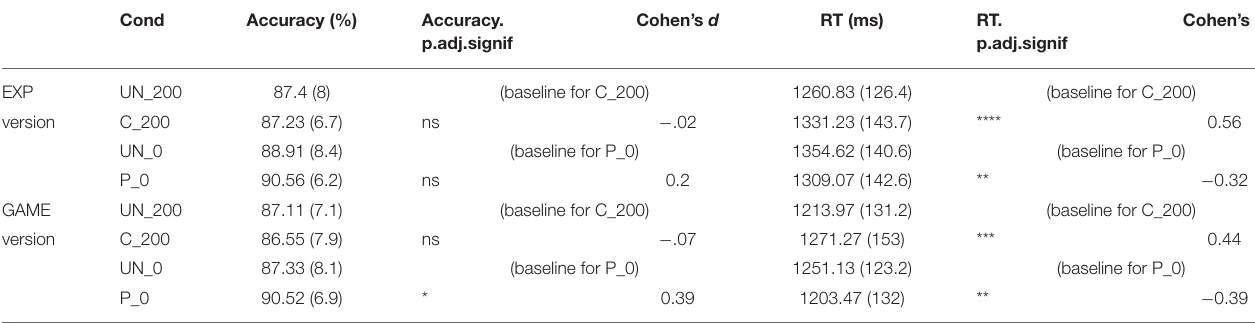
TABLE 4 | Experiment 4: Accuracy (%) and RT (ms) are shown as mean (s.d.).